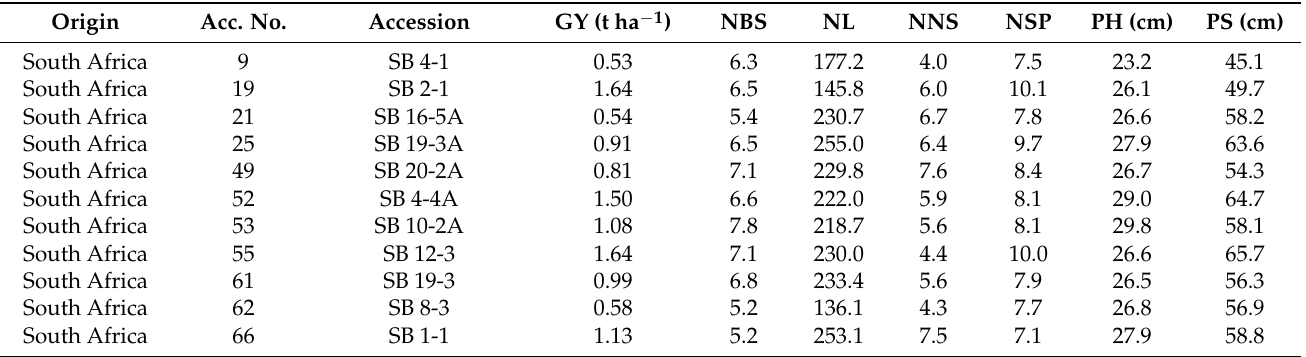
Table 4. Means of grain yield and yield components of bambara groundnut accessions from combined analysis of accessions planted at Vaalharts and Roodeplaat during the 2016–2017 cropping